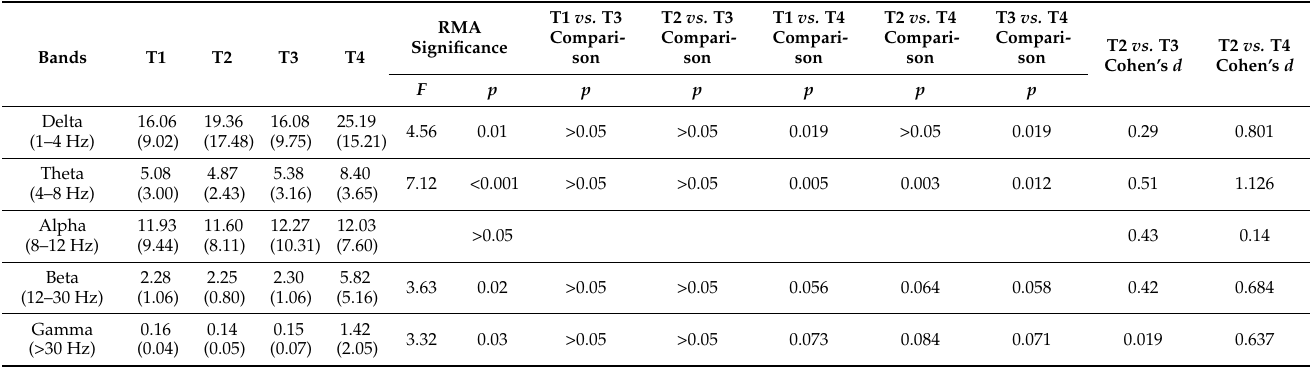
Table 2. Frontal electrodes power (mean (SD)) in the brain oscillatory bands at the four measurements (T1–T4) and intervention